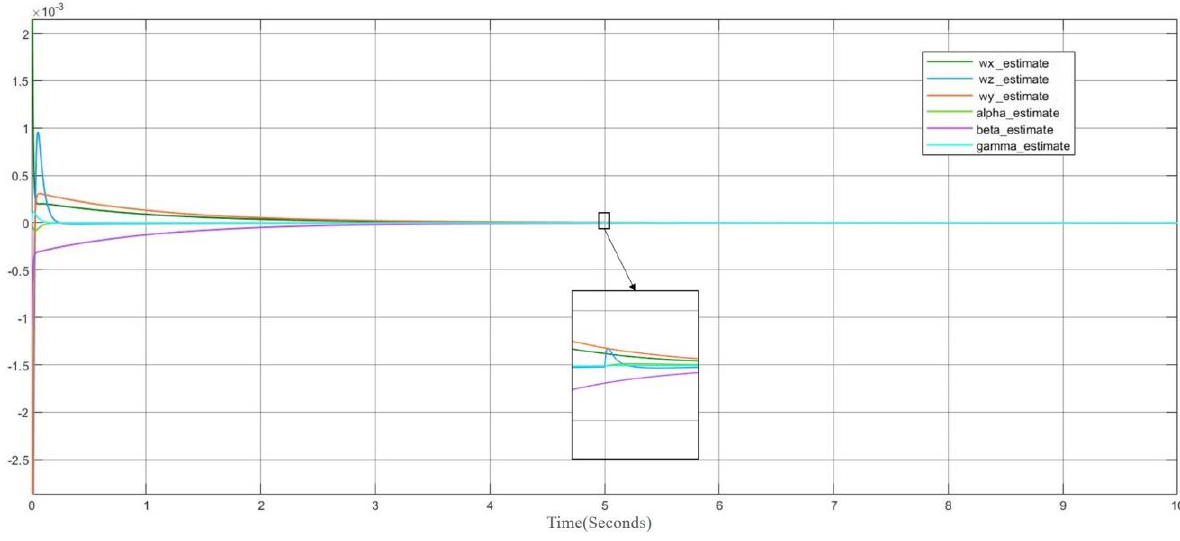
Figure 12. Input 2’s 80% PLOE fault detection simulation.